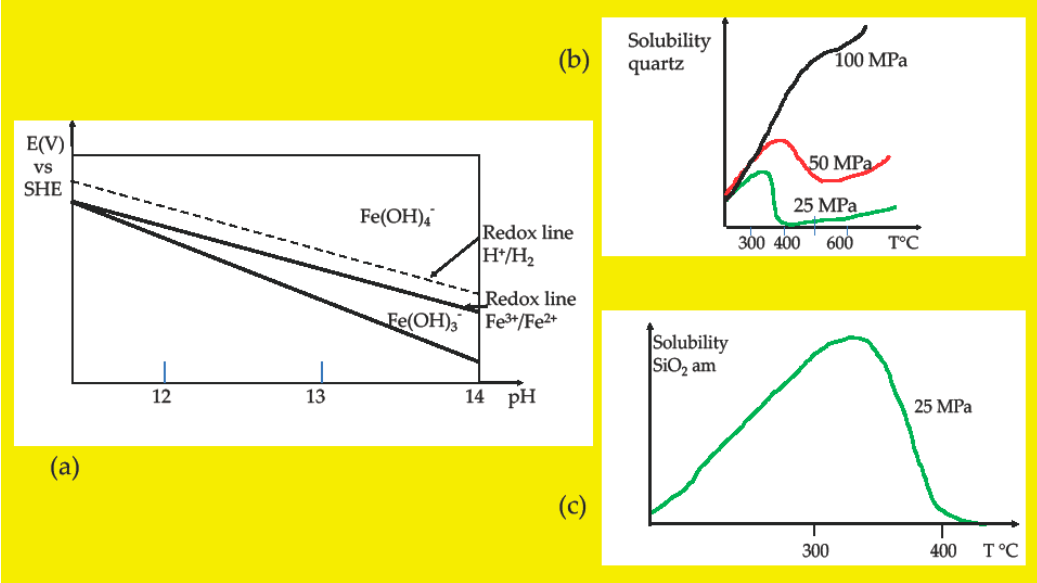
Figure 2. Schematic diagrams to aid the comprehension of the studies on fayalite dissolution and oxidation [2–8]. Only small parts of the original diagrams are approximately reproduced. ( a ) Pourbaix diagram for the water–iron system at 350 °C, 25 MPa, 10 − 6 mol/kg of dissolved product species; the original was drawn and published in 2012 by Cook and Olive [21]; SHE, standard hydrogen electrode. ( b ) Solubility diagram of quartz (SiO 2 ) in water; the original was drawn and published in 2011 by Smith and Fang [22]. ( c ) Solubility diagram of amorphous silica (SiO 2 am); the original was drawn and published in 2013 by Karasek et al. [23].